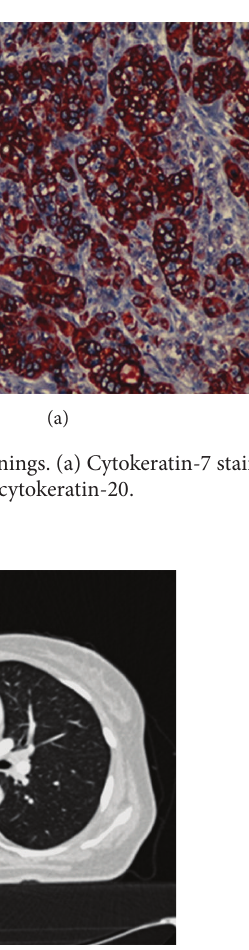
Figure 4: Axial CT image showing well-defined mass lesion causing mild compression of pulmonary artery